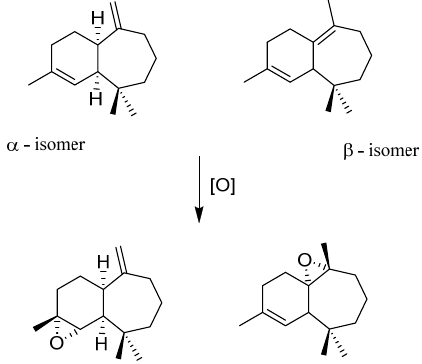
Figure 13. α and β isomers of himachalenes and related epoxides.